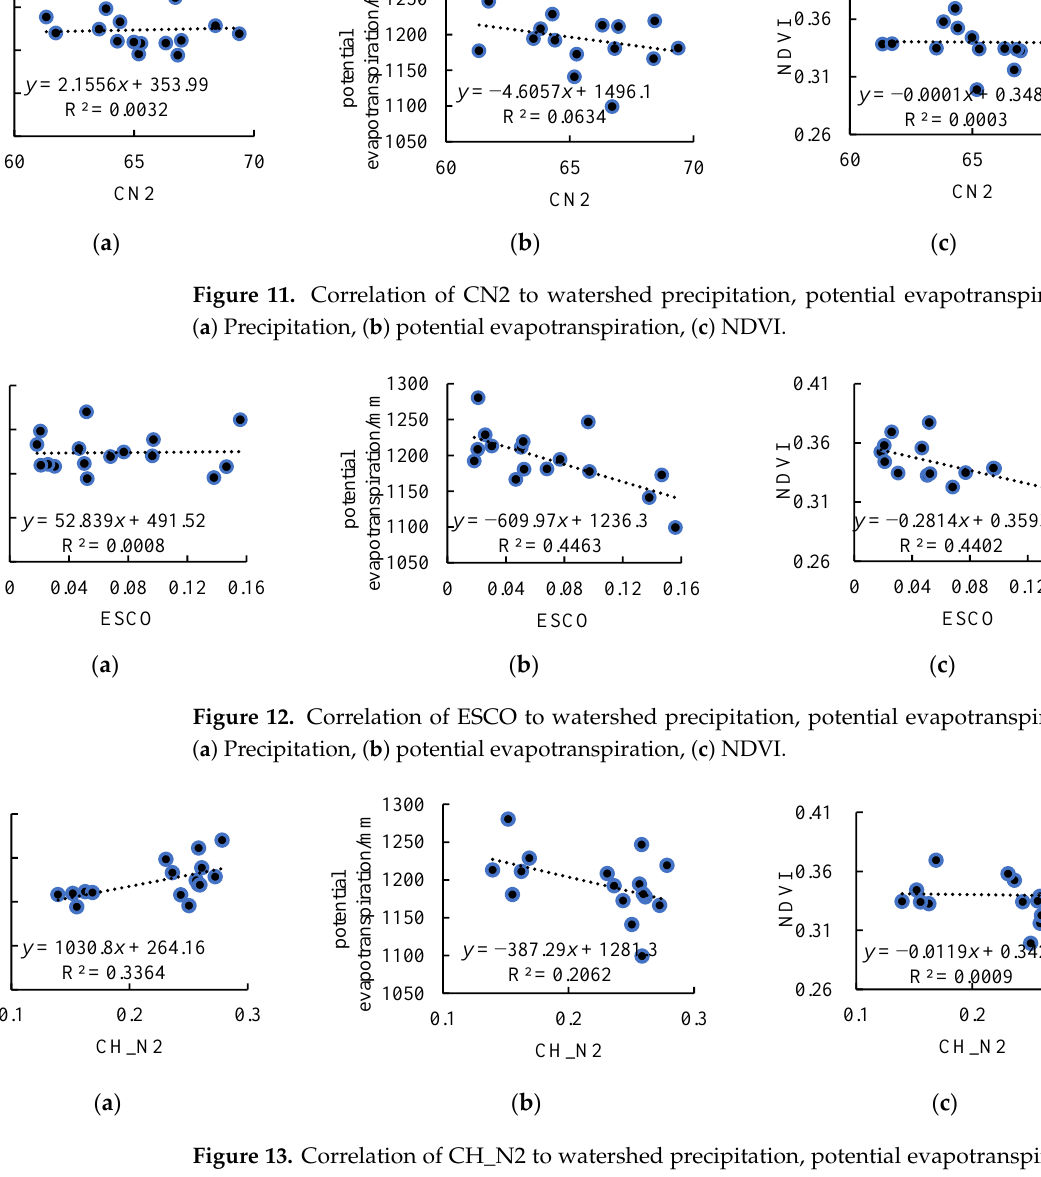
( c ) Figure 14. Correlation of ALPHA_BNK to watershed precipitation, potential evapotranspiration, NDVI. ( a ) Precipitation, ( b ) potential evapotranspiration, ( c ) NDVI. In summary, all four parameters of the SWAT model in the upper reach of the Wei River Basin show a certain correlation with potential evapotranspiration, and some pa- rameters have a correlation with precipitation or NDVI, which indicates that the changes of the hydrological model parameters in the upper reach of the Wei River Basin are closely related to the dynamic changes of potential evapotranspiration. Therefore, po- tential evapotranspiration can be used as a representative factor of the dynamic change of model parameters. 5. Conclusions In this study, the upper reach of the Wei River is selected as the study area, and the temporal and spatial evolution of the ecological hydrometeorological elements in the study area is revealed using the linear regression method and the cumulative anomaly method. The time-varying parameter series of the hydrological model is obtained based on the SWAT model in each year. The time-varying characteristics of the model param- eters and environmental indicators such as precipitation, potential evapotranspiration and NDVI were analyzed, and the response relationship between them was identified. In addition to the decreasing trend of annual precipitation in the basin, the hydro- meteorological elements such as annual potential evapotranspiration, annual average temperature, annual runoff depth and annual average NDVI all showed an increasing trend. The annual precipitation and annual runoff depth series in the basin did not change abruptly, but the annual mean temperature series and the annual potential evapotranspiration series jumped significantly around 1997 and 1994, respectively. Except for the six years of 2002, 2004, 2008, 2009, 2016 and 2017 in 2002 – 2017, the daily runoff simulation accuracy in the other 10 years met the requirements. The four model parameters of CN2, ESCO, CH_N2 and ALPHA_BNK all fluctuated with time during the study period. The number of runoff curves (CN2) and CH_N2 had no obvious